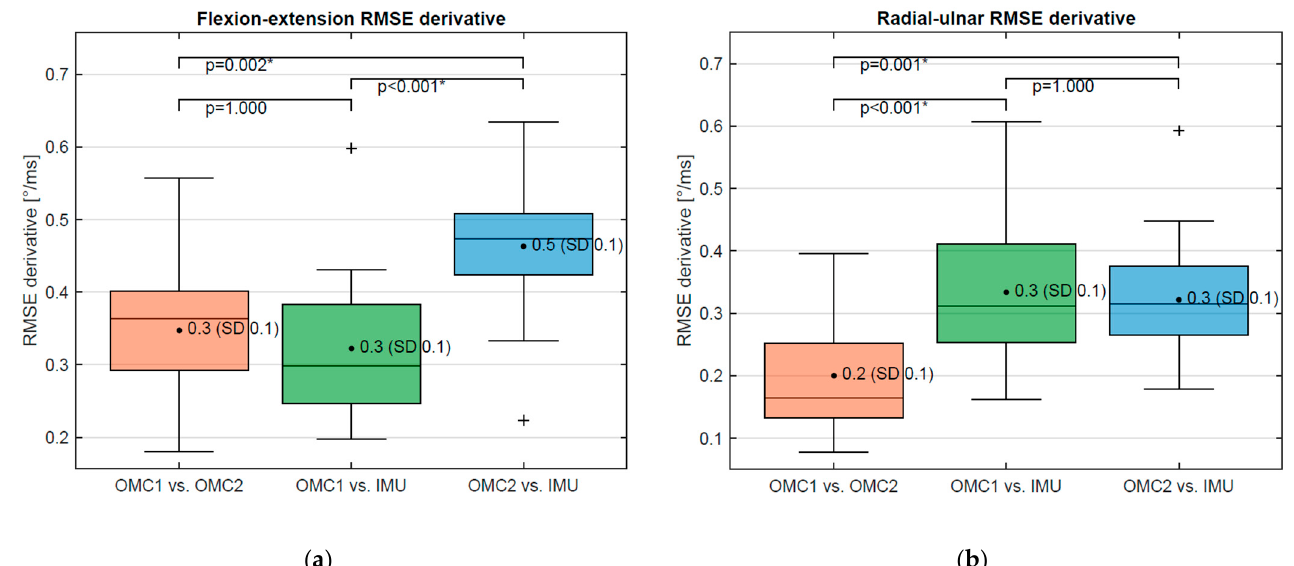
Figure 7. ( a ) RMSE of flexion–extension (filtered) derivative between OMC1, OMC2, and IMU acquisition systems and ( b ) RMSE of radial–ulnar deviation (filtered) derivative between OMC1, OMC2, and IMU acquisition systems. For Values marked as *, the difference is statistically significant. The symbols are statistical outliers and can be captioned as Table 1. Summary of the mean (±SD) ROM DTM in both the flexion–extension and radial–ulnar deviation planes for each system, as well as the mean absolute difference (MAD) and the coefficient of variation (CV) between the different systems. MAD ROM ROM ROM IMU OMC1 OMC2